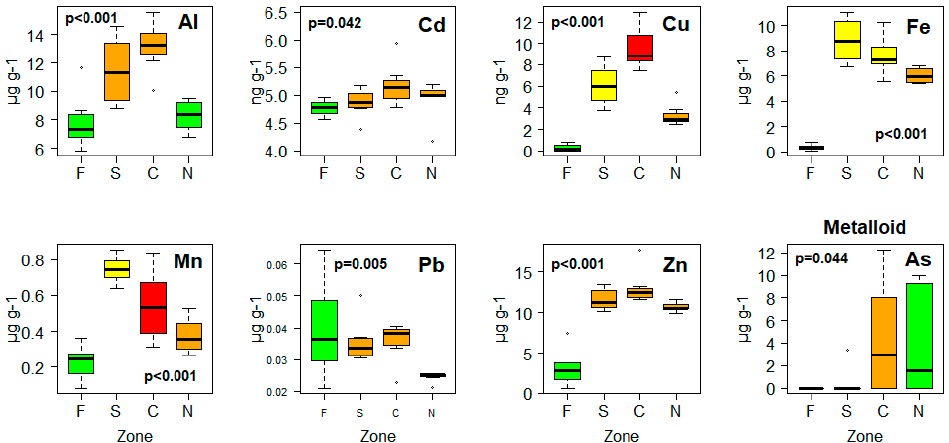
Figure 2. Boxplot of heavy metals and metalloid accumulation in the Marchantia polymorpha collected from di ff erent zones in the Zamora River. Al, Cd, Fe, Mn, and Zn: One-way ANOVA followed by a Tukey test. As, Cu, and Pb: Kruskal–Wallis ANOVA followed by a Dunn’s test. Di ff erent colors for each zone are considered significant ( p < 0.05). Table 1. Mean concentration ( µ g g − 1 ) and standard error (SE) of heavy metals and arsenic in Marchantia polymorpha by di ff erent zones. Control South Center